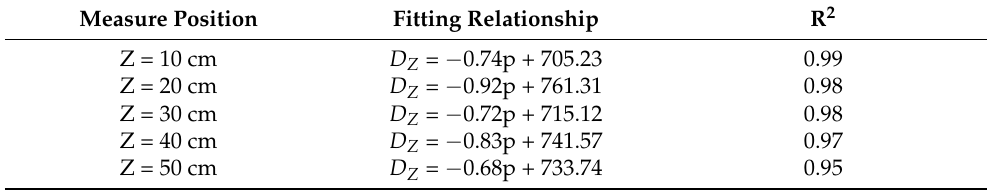
Table 3. Fitting relationship between droplet size D Z and spray pressure p at measure positions.